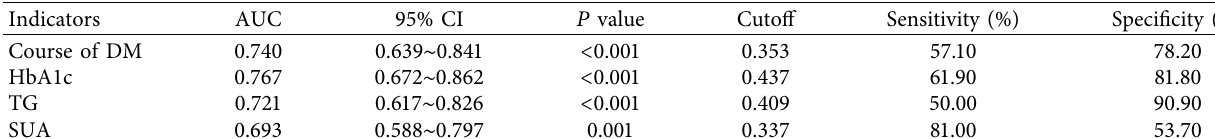
Table 4: ROC analysis of DR risk factors.